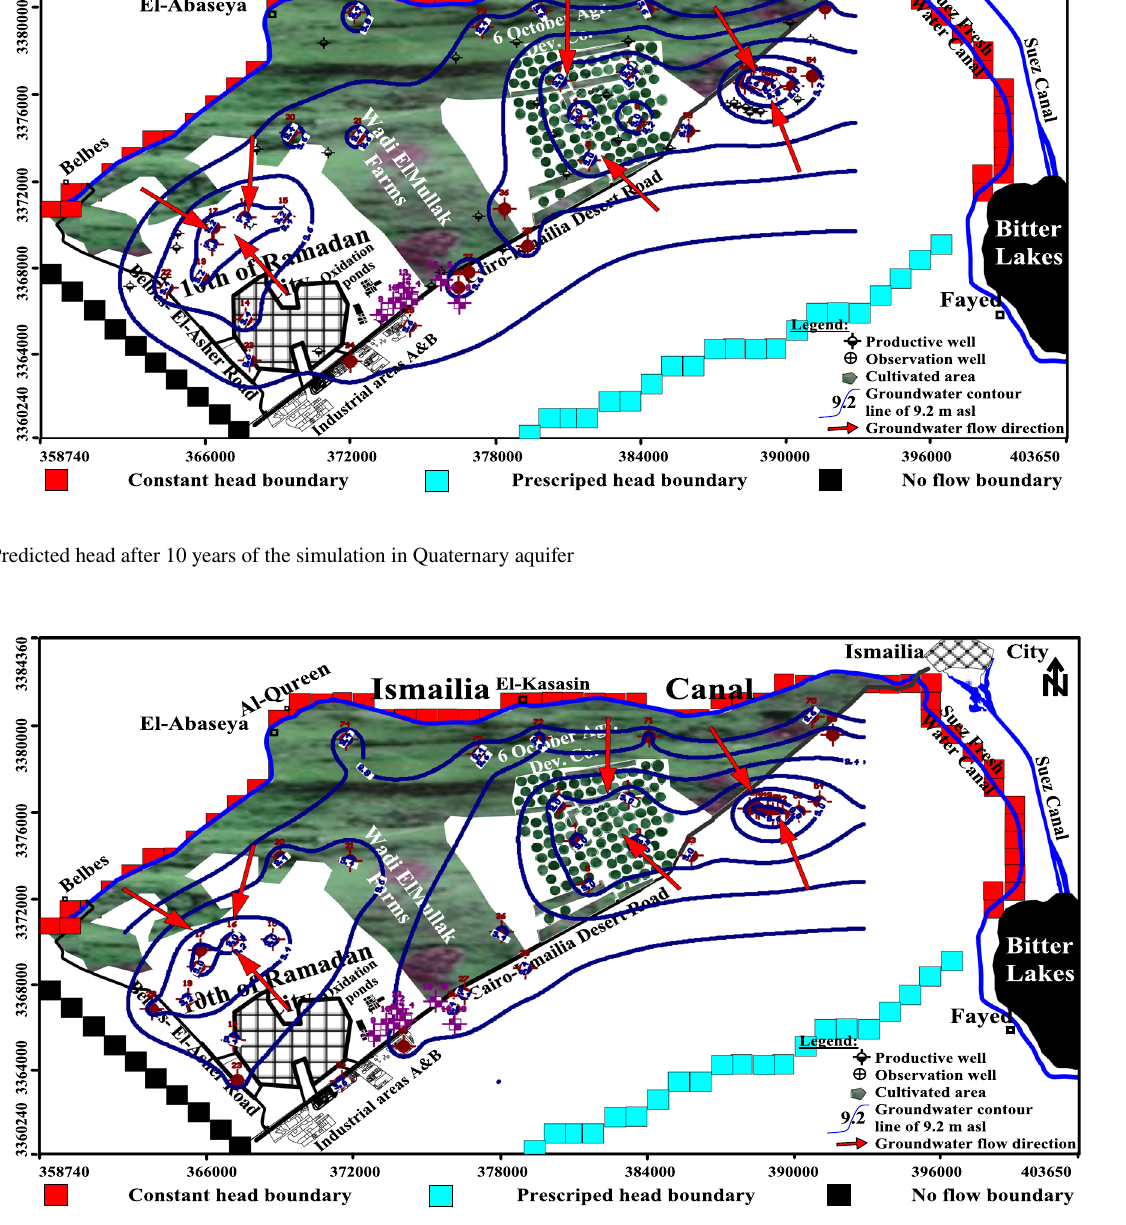
Fig. 9 Predicted head after 20 years of the simulation in Quaternary